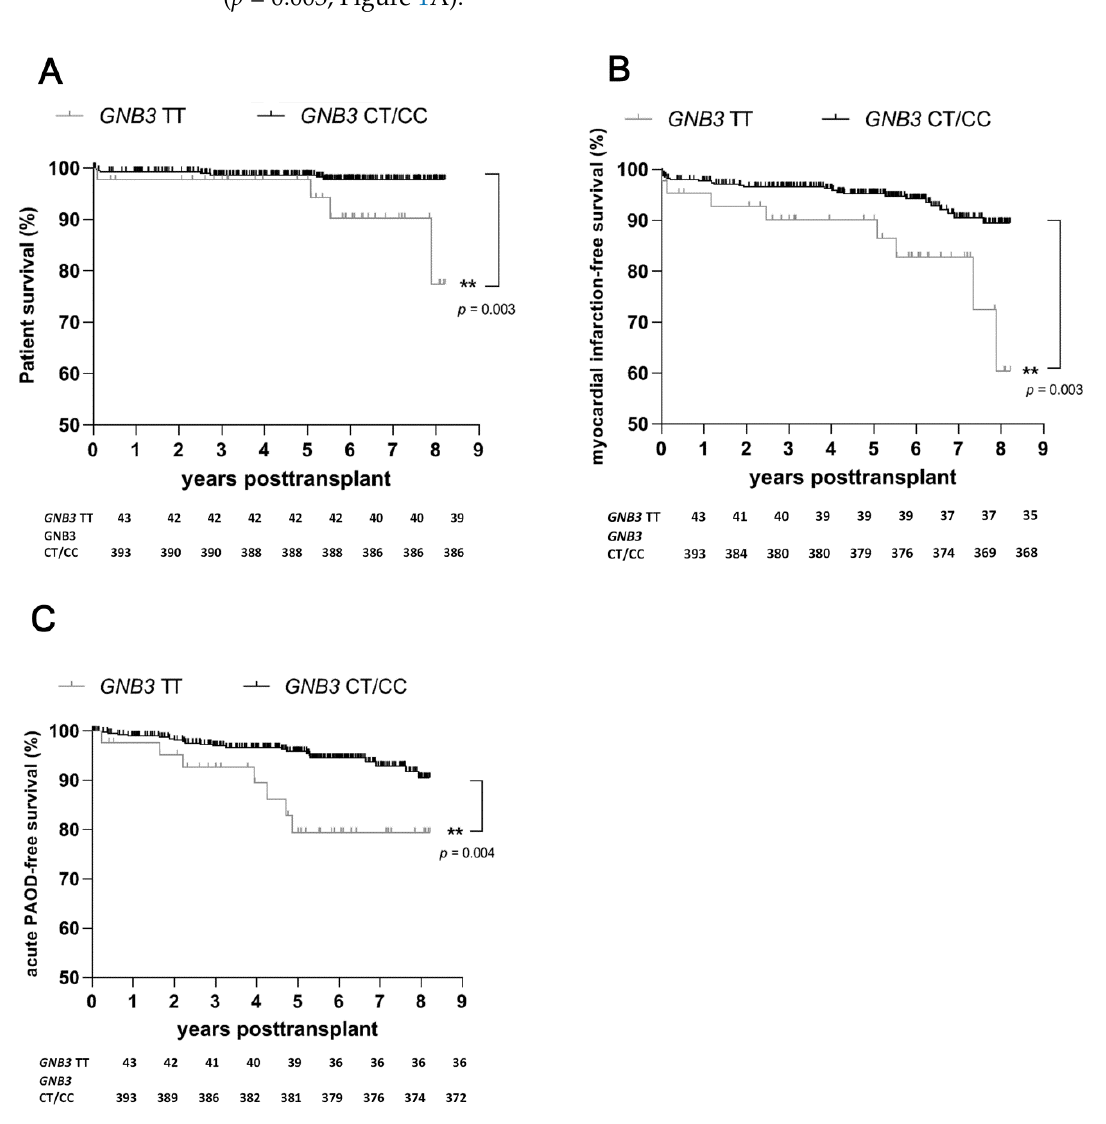
Figure 1. Occurrence of acute cardiovascular events among carriers of TT genotype and carriers of the CT/CC genotype of GNB3 during an 8-year follow-up period after transplant. ( A ) Death due to cardiovascular event according to the genotype of GNB3 ( p = 0.003). ( B ) Survival dependent on the occurrence of acute myocardial infarction after transplant among carriers of the TT or the CT/CC genotype of GNB3 ( p = 0.003). ( C ) Survival dependent on the development of acute peripheral artery occlusive disease (PAOD) after transplant among carriers of the TT or the CT/CC genotype of GNB3 ( p = 0.004). **, p = 0.01. PAOD, peripheral artery occlusive disease. During the follow-up period after transplant, significantly more TT genotype carriers than CT/CC genotype carriers experienced acute MI ( p = 0.007; Table 1). Additionally, the frequency of MI-free survival after renal transplant was lower among TT genotype carri- ers ( p = 0.003; Figure 1B).